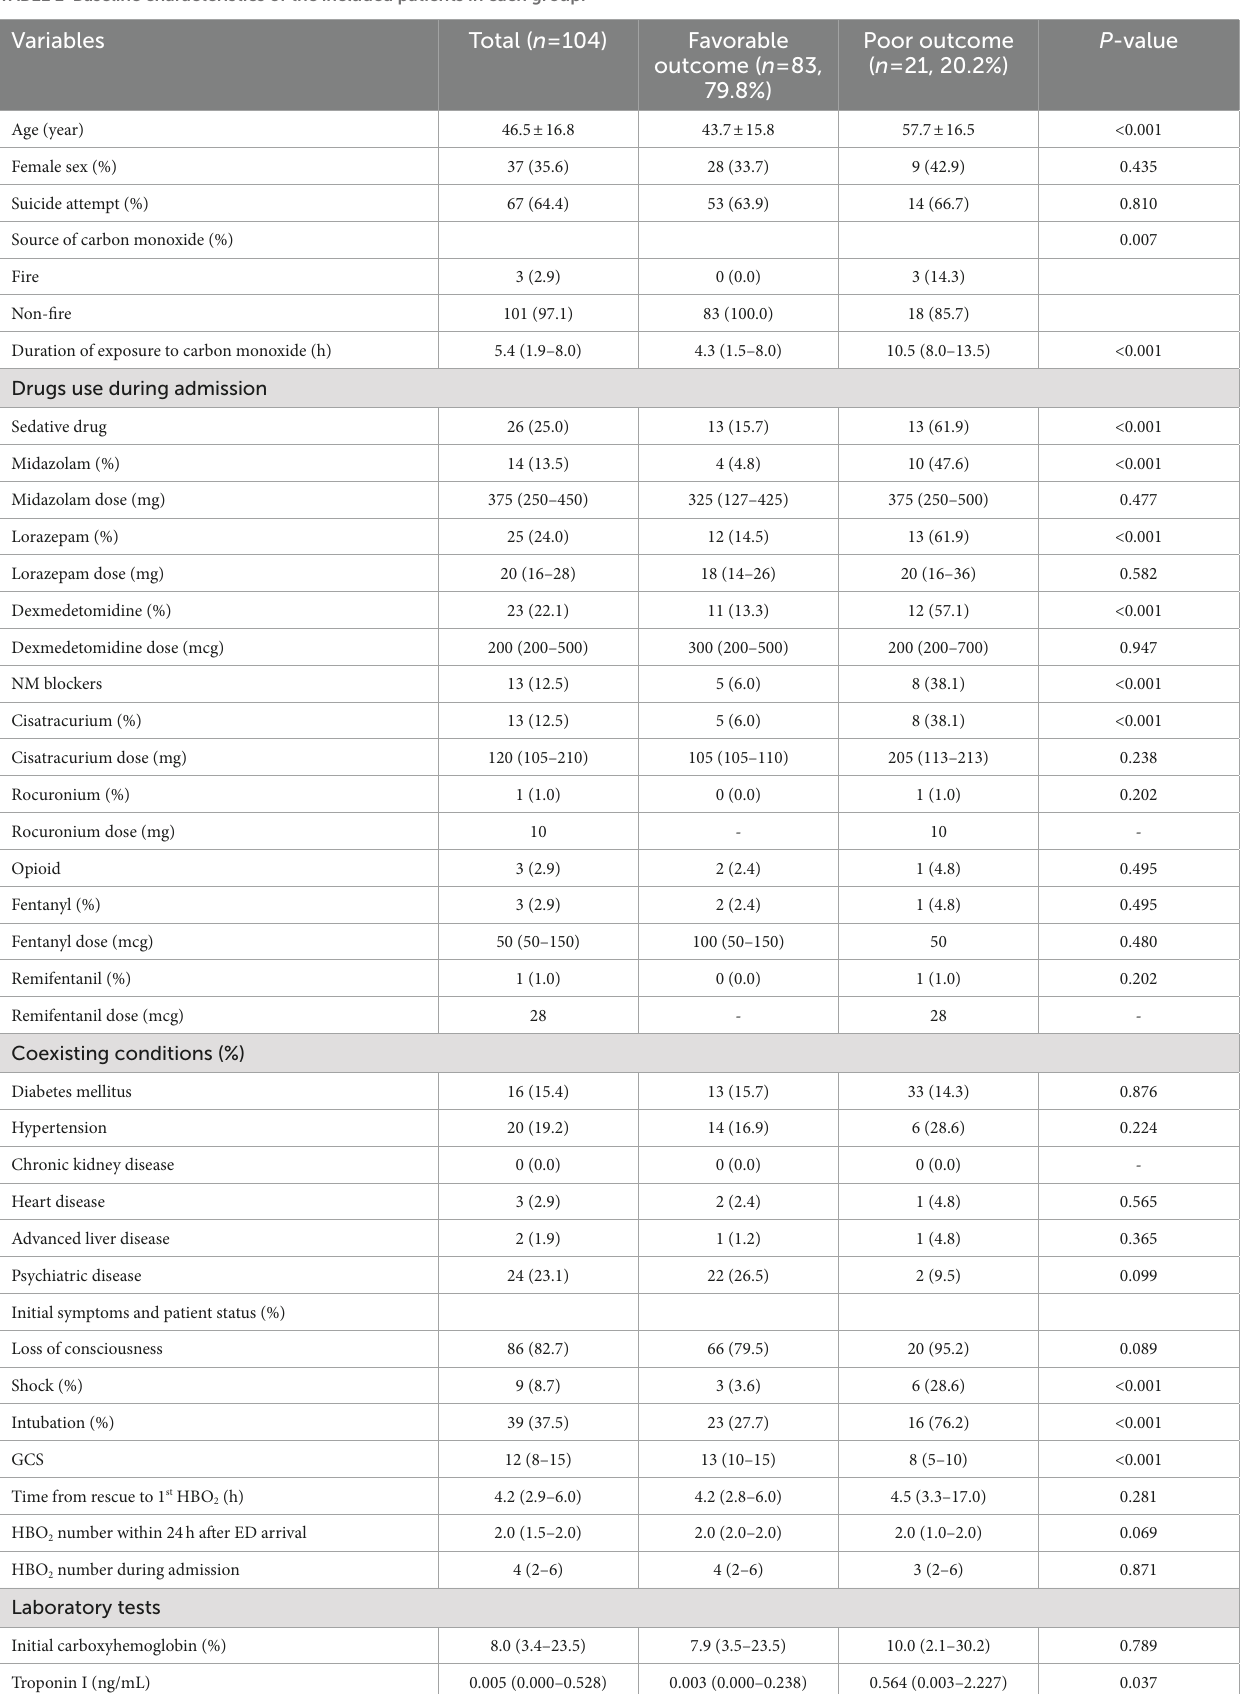
TABLE 1 Baseline characteristics of the included patients in each group.